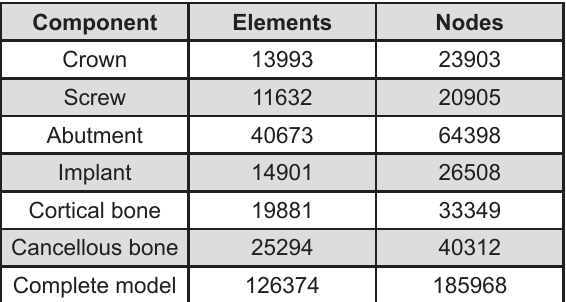
Figure 4- Element and node numbers in the typical mesh implant system components